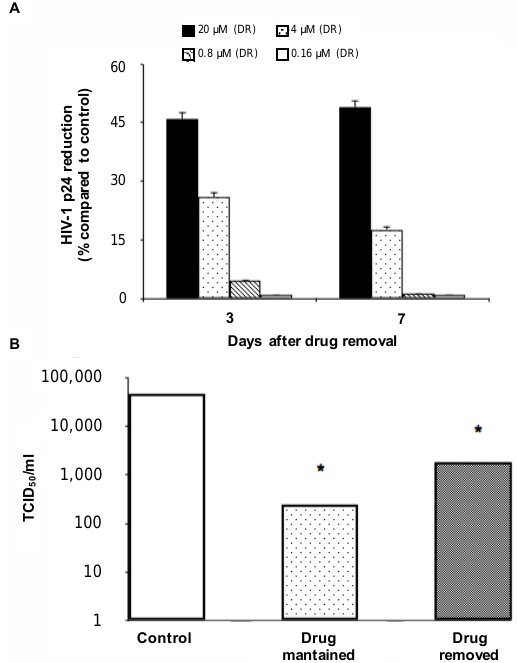
Figure 4. ( A ) Reduction of HIV-1 p24 production at three and seven days after drug removal in chronically-infected MDM. Statistical analysis was performed by the χ 2 test. * p < 0.001; ( B ) HIV-1 titers (expressed as TCID 50/mL ) determined using supernatants from untreated HIV-1-infected MDM, AMP-treated HIV-1-infected MDM and HIV-1-infected MDM in which the drug was removed. Statistical analysis was performed by the χ 2 test. * p < 0.001. DR: drug-removed.